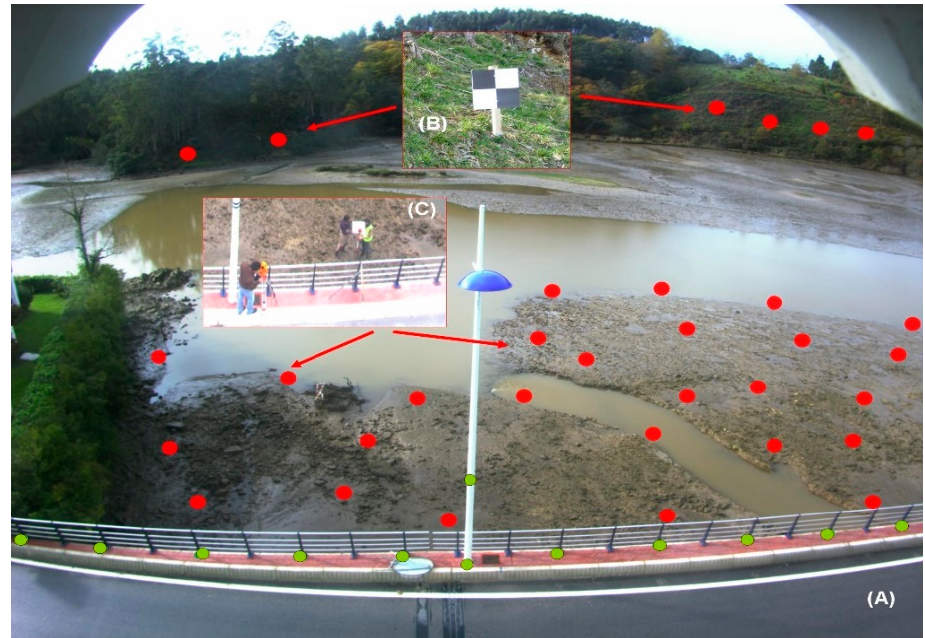
Figure 6. Points of selected field controls for Camera 1. ( a ) Fixed points at bridge's footbridge. ( b ) Vinyl layer plastic targets. ( c ) Fixed points made by vinyl targets coupled to wooden structures. Following the same process for Camera 2 and Camera 3 of the "La Rabia" station, the control